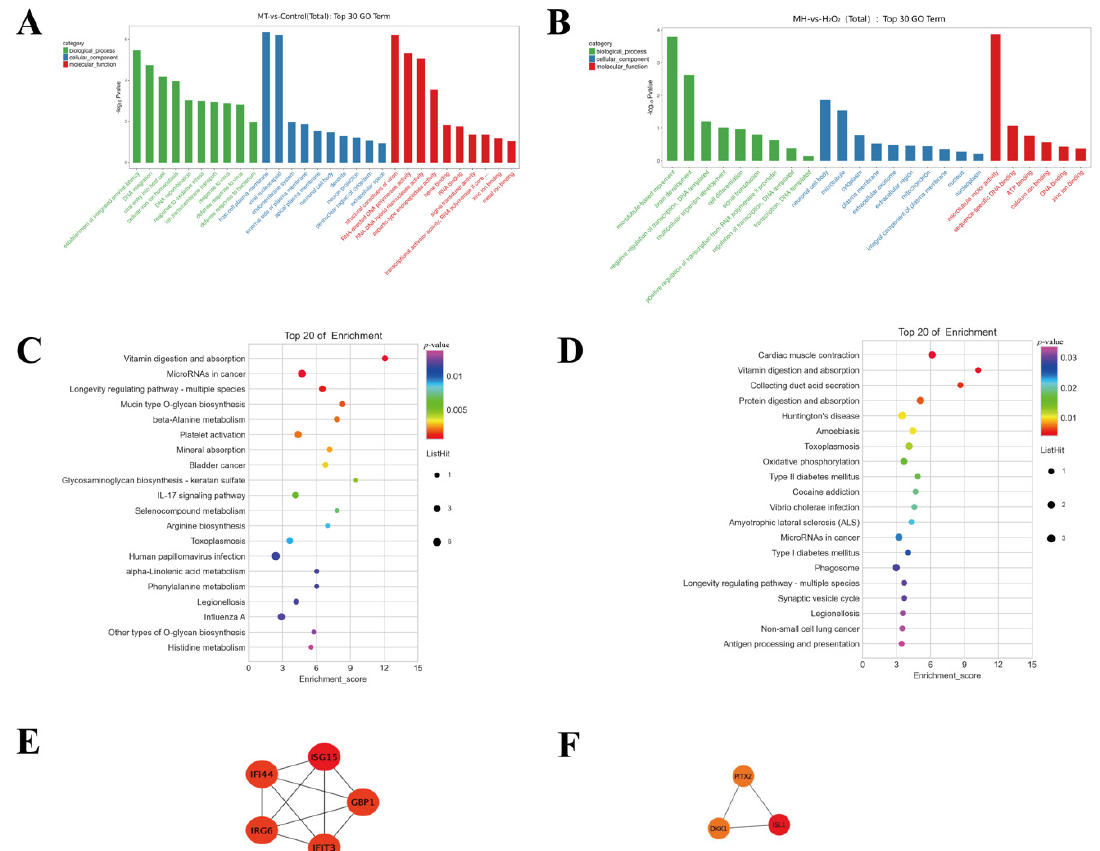
Figure 5. KEGG pathway enrichment, GO functional annotation and PPI network analysis for DEGs. ( A ) the top 30 enriched GO terms (MT vs. CON); ( B )the top 30 enriched GO terms (MH vs. H 2 O 2 ); The y -axis represents enrichment factor. The x -axis represents GO terms. The pathways with numbers of differential genes greater than 2 were screened. ( C ) the top 20 KEGG enriched pathways (MT vs. CON); ( D ) the top 20 KEGG enriched pathways (MH vs. H 2 O 2 ); The y -axis The y-axis corresponds to the KEGG Pathway. The x -axis shows the enrichment factor. The color of the dot represents the p -value and the size of the dot represents the number of DEGs mapped to the reference pathways. ( E ) Module 1 (MT vs. CON). ( F ) Module 2 (MH vs. H 2 O 2 ). The color indicate in red (high score) and yellow (low score).